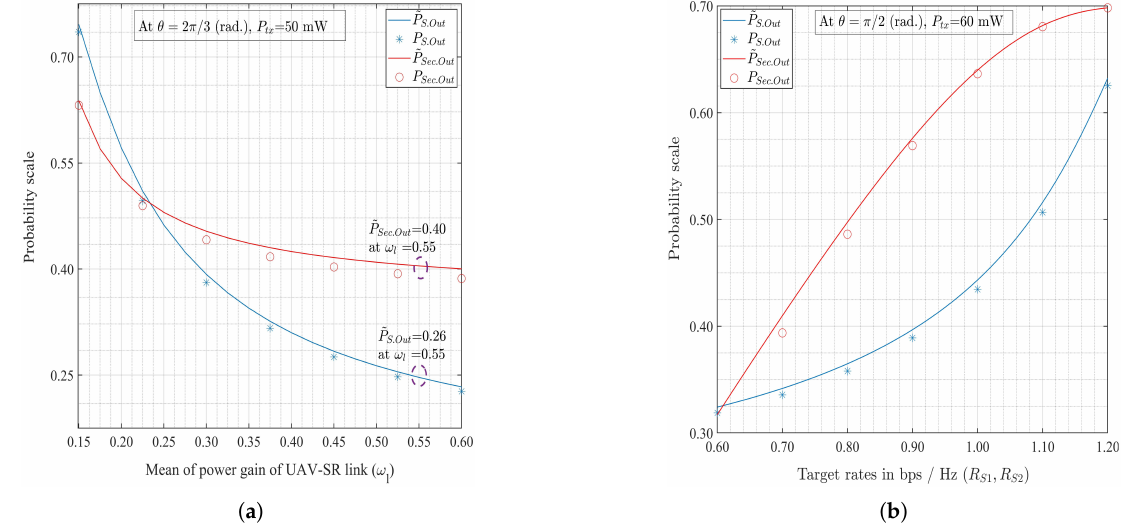
Figure 4. Monotonic functions of connection outage probability, secrecy outage probability vs. ( a ) mean (expectation) of | h l | 2 and ( b ) target rates.